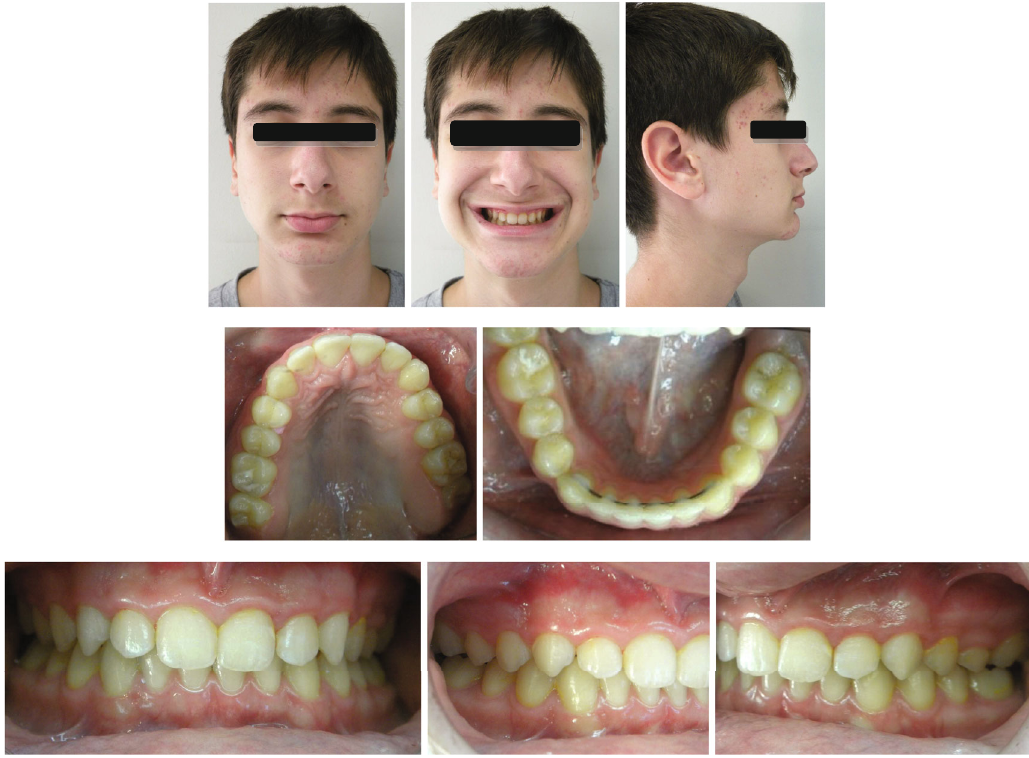
Figure 8: Post-treatment